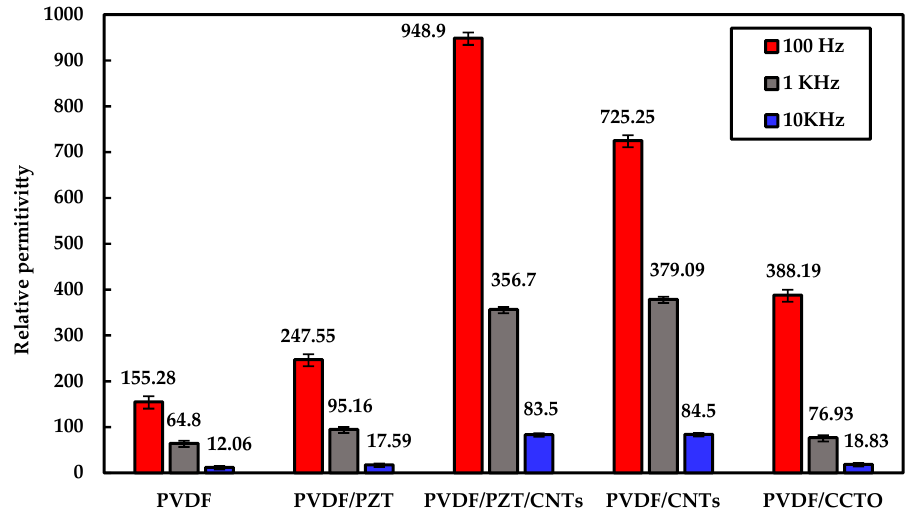
Figure 7. Frequency-dependent dielectric constant of PVDF mixed with different Figure 7. Frequency ‐ dependent dielectric constant of PVDF mixed with different fillers.